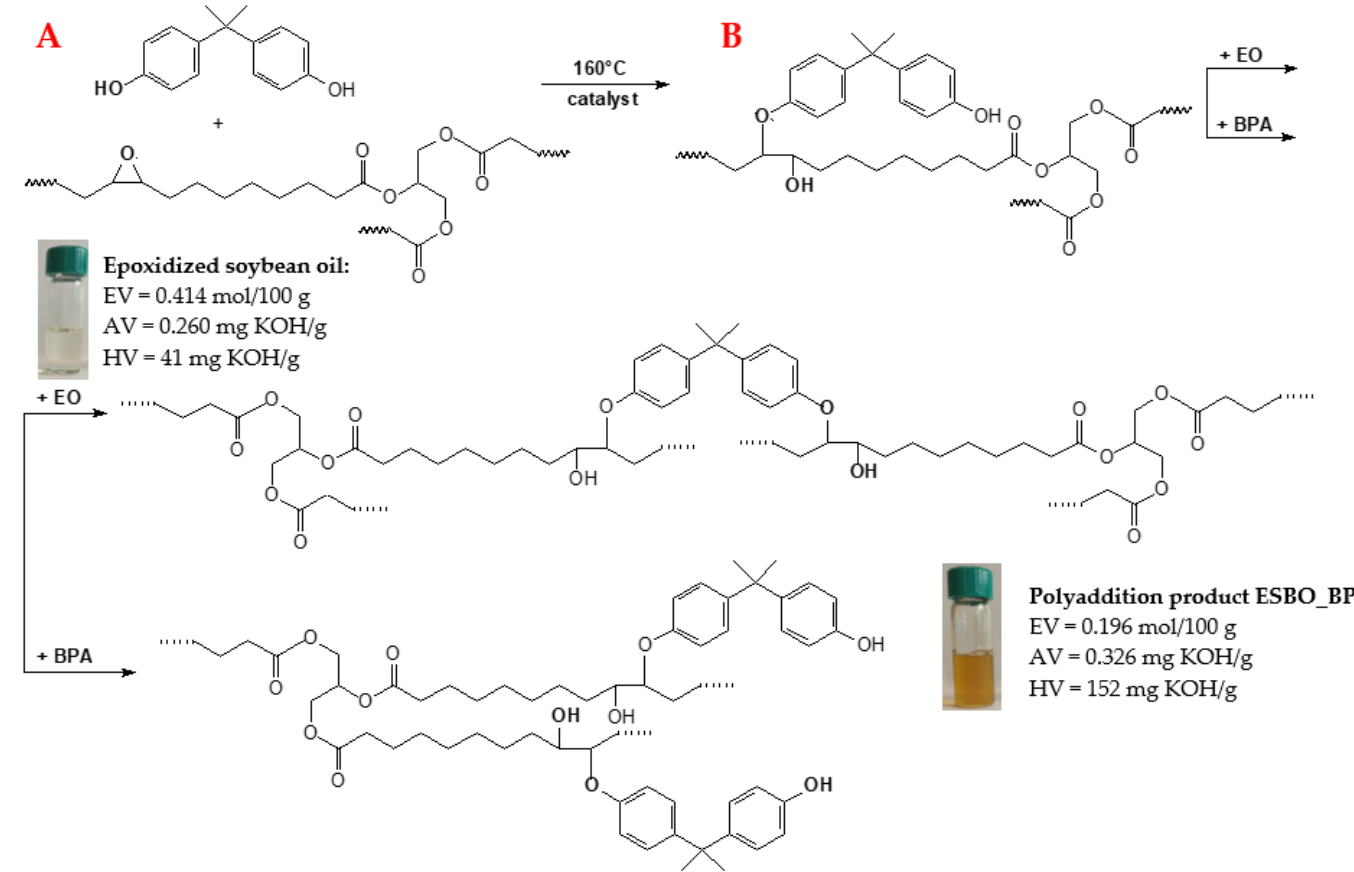
Figure 1. The epoxy fusion process for epoxidized soybean oil and bisphenol-A: ( A ) reaction between molecules of epoxidized oil and bisphenol; ( B ) linear oligomer formation; ( C ) subsequent reactions leading to the formation of branched oligomers.